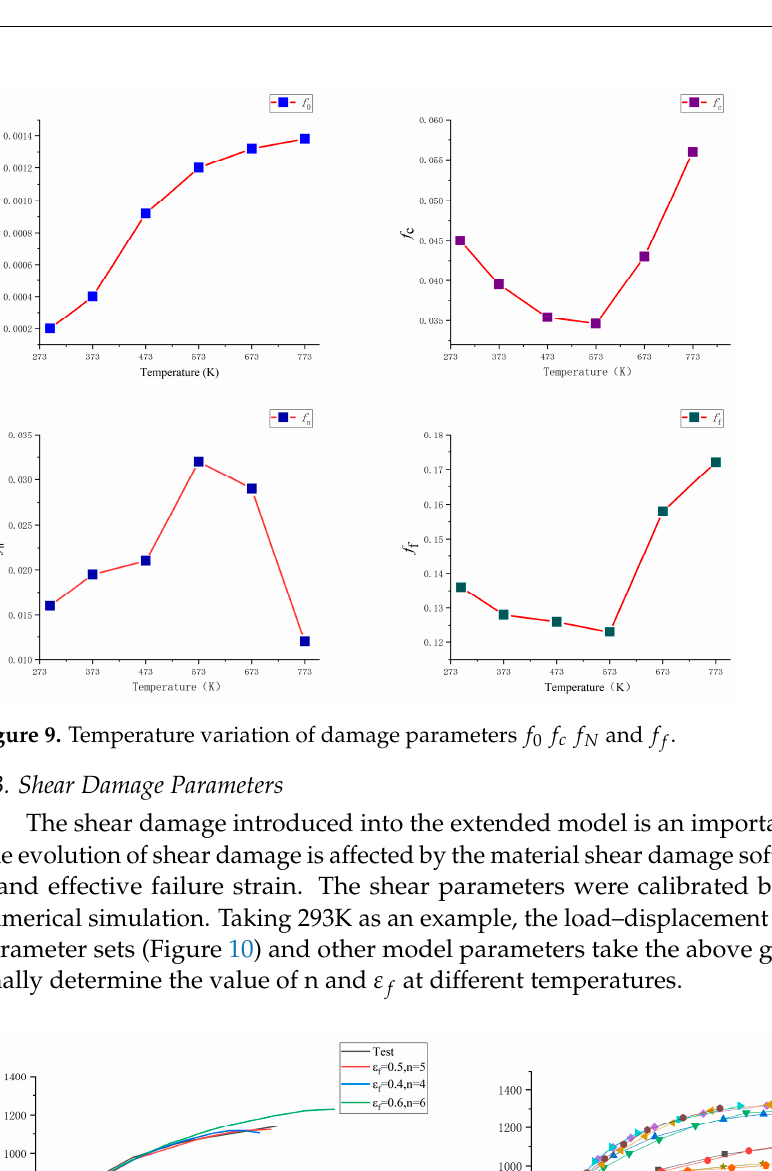
Figure 9. Temperature variation of damage parameters 0 f c f N f and